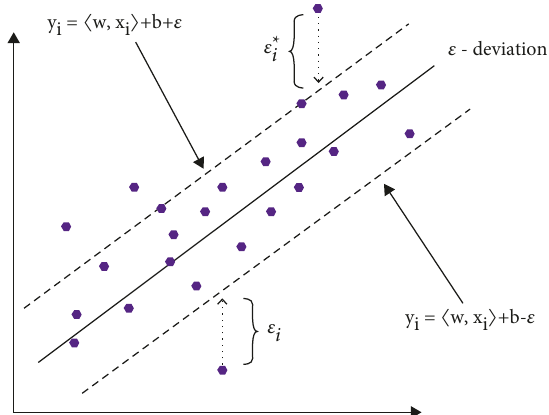
Figure 7: Support Vector Regression